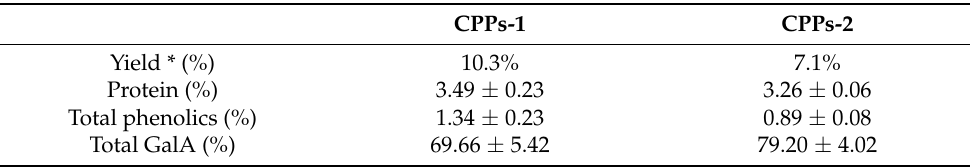
Table 5. Yield and chemical composition of CPPs-1 and CPPs-2.